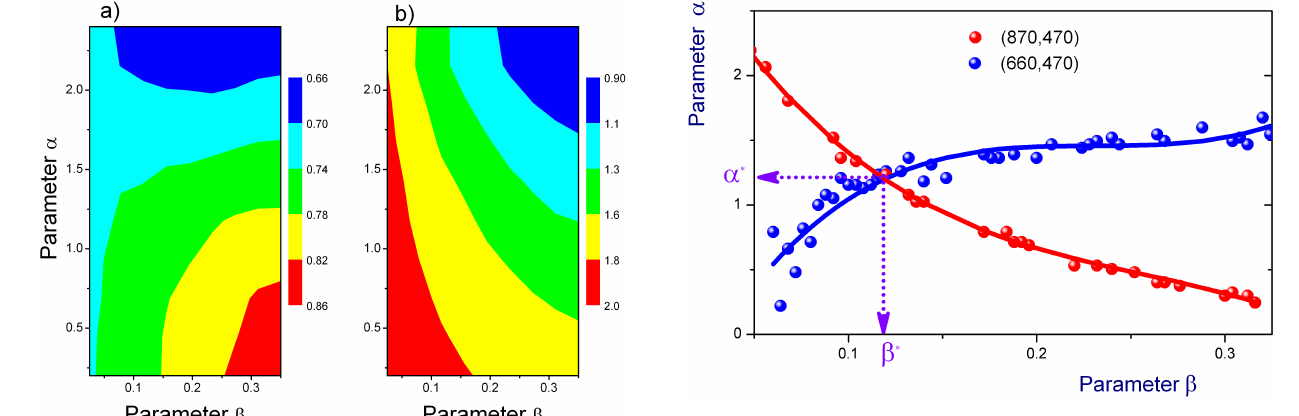
Fig. B1. Example of model reflectance ratios ( ρ ) generated for SZA=40, and assumed spectral values of the surface albedo A S ( 470 ) = 0 . 06, A S ( 660 ) = 0 . 07, and A S ( 870 ) = 0 . 22.